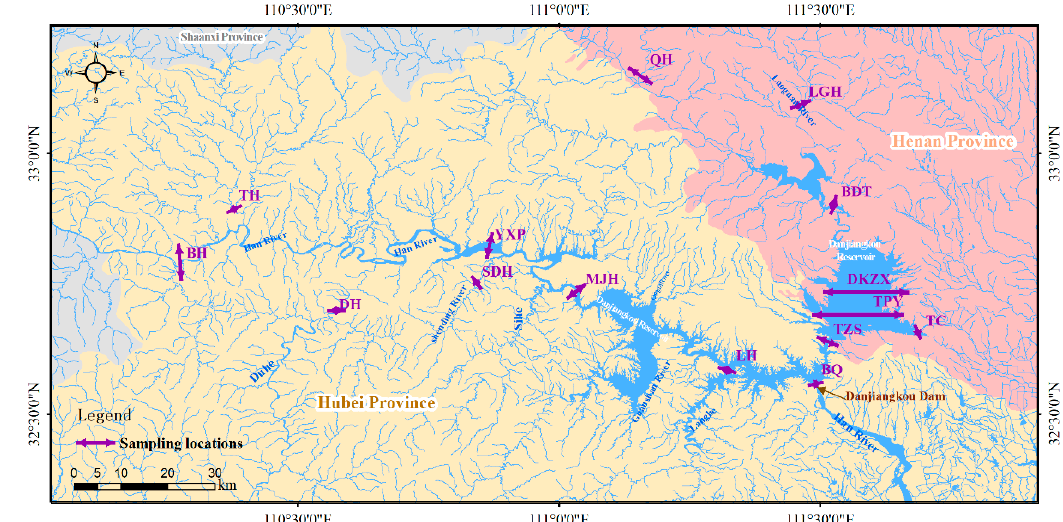
Figure 1. Sampling locations for the antimony concentrations in the water and sediments in Dan- jiangkou Reservoir. Reservoirs located in Henan Province are called the Dan sub-reservoir, and those located in Hubei Province are called the Han sub-reservoir.